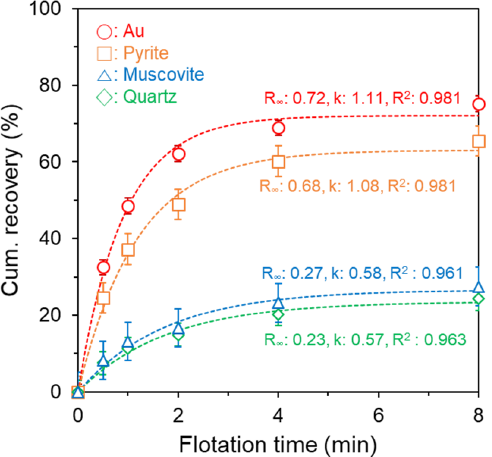
Figure 5. Cumulative flotation recovery of Gasado gold ore for gold (red circle), pyrite (orange rectangular), muscovite (blue triangle), and quartz (green diamond) as a function of flotation time. Dotted line represents flotation recovery calculated using Equation (1). R ∞ is the maximum recovery, k the flotation rate constant, and R 2 the coefficient of determination.